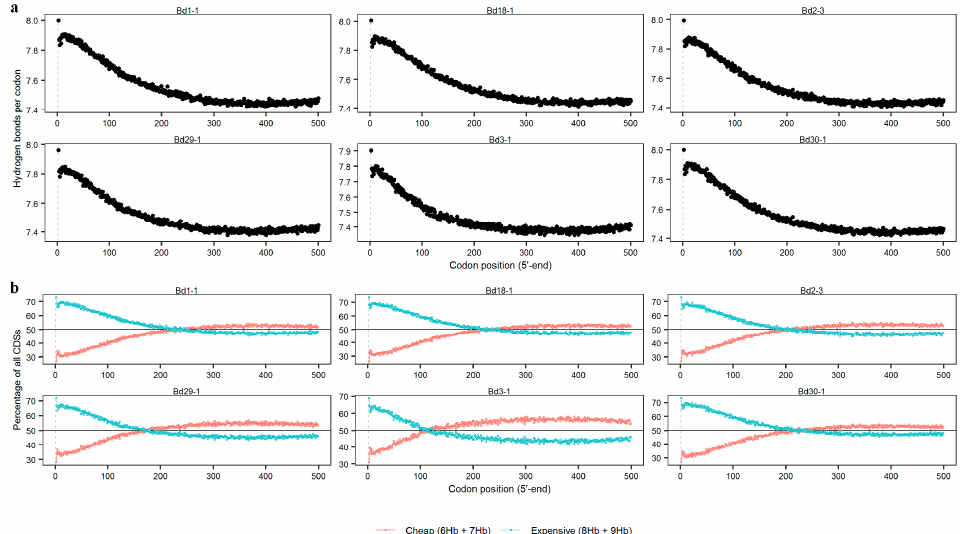
Figure 6. The relationship between the number of hydrogen bonds and codon position. ( a ) The hydrogen bonds per codon at the 5 ′ -ends of the CDSs in the six lines; ( b ) The percentages of the two type codons at the 5 ′ -ends of the CDSs in the six lines.